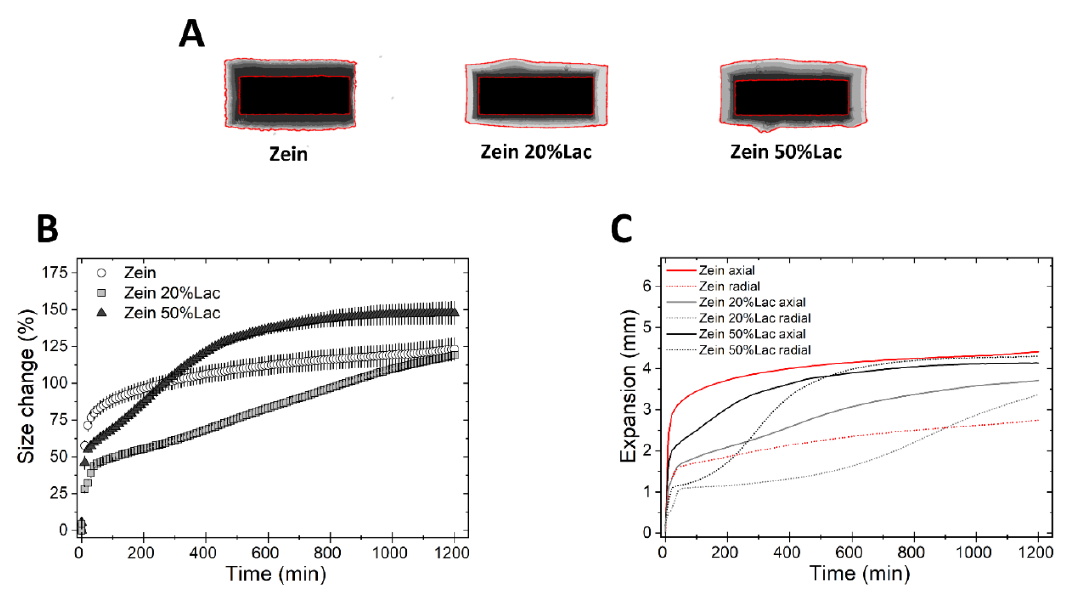
Figure 3. Swelling of tablets made of binary mixtures of zein and lactose (20% and 50% w / w ). ( A ) Sum of Z-stack of images. The two red lines are the outlines of the tablet at time 0 and at 20 h. ( B ) Swelling measured as the change of the projected area of tablets (mean ± SD, n = 3) as a function of time. ( C ) Axial and radial swelling of tablets (mean ± SD, n = 3) as a function of time.